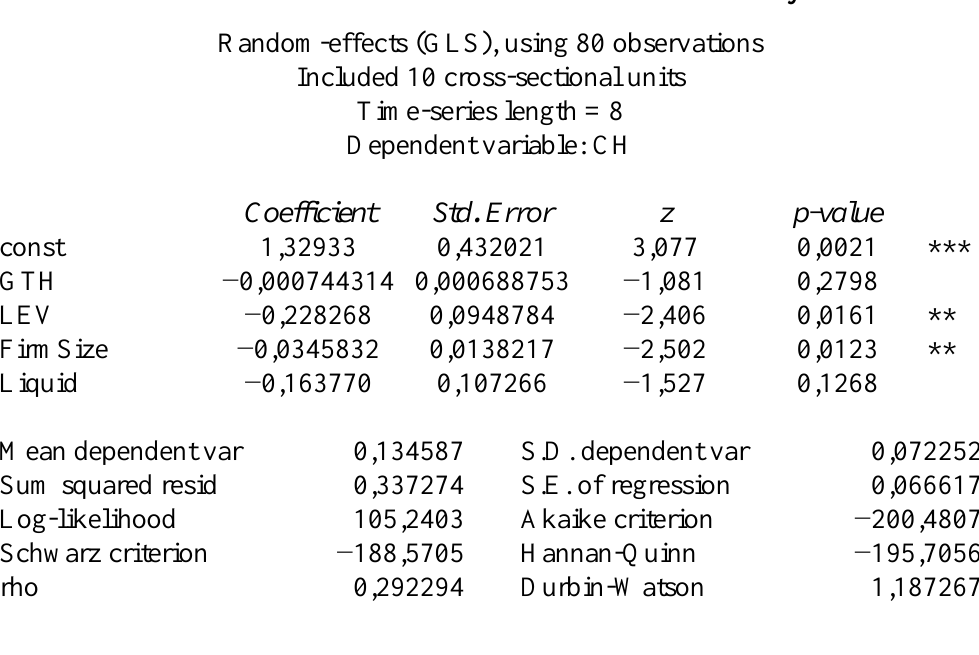
Table 3. Results of the Random Effect Model